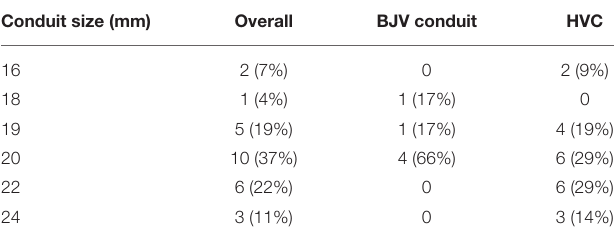
TABLE 2 | The selection of conduit size and conduit type in the entire cohort. Conduit size (mm)